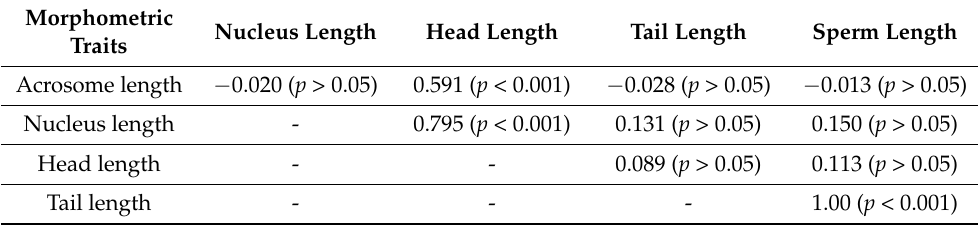
Table 3. Pearson coefficients (r) showing correlation between the morphometric dimensions of drone spermatozoa (G1).